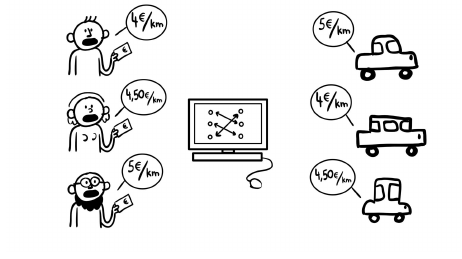
Figure 2. Illustrationofthe doubleauctionmechanism.Indouble auctionmechanisms,each passenger makesa bid forthe priceof theirjourney,whileeach drivermakesa bid fortheircommission. The providerthen acts as a matchmakerto determinewhich passenger is servedby each